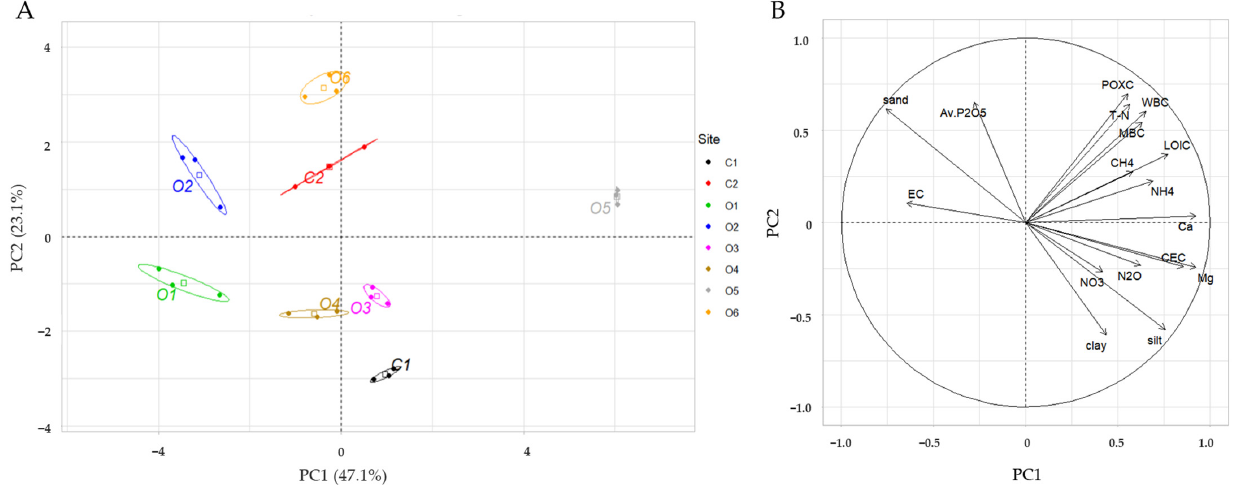
Figure 4. PCA of the biogeochemical properties of paddy soils with different fertilization practices. ( A ) Component scores for first two principal components of eight different paddy fields. ( B ) Loading plot of soil carbon fractions and biogeochemical parameters.